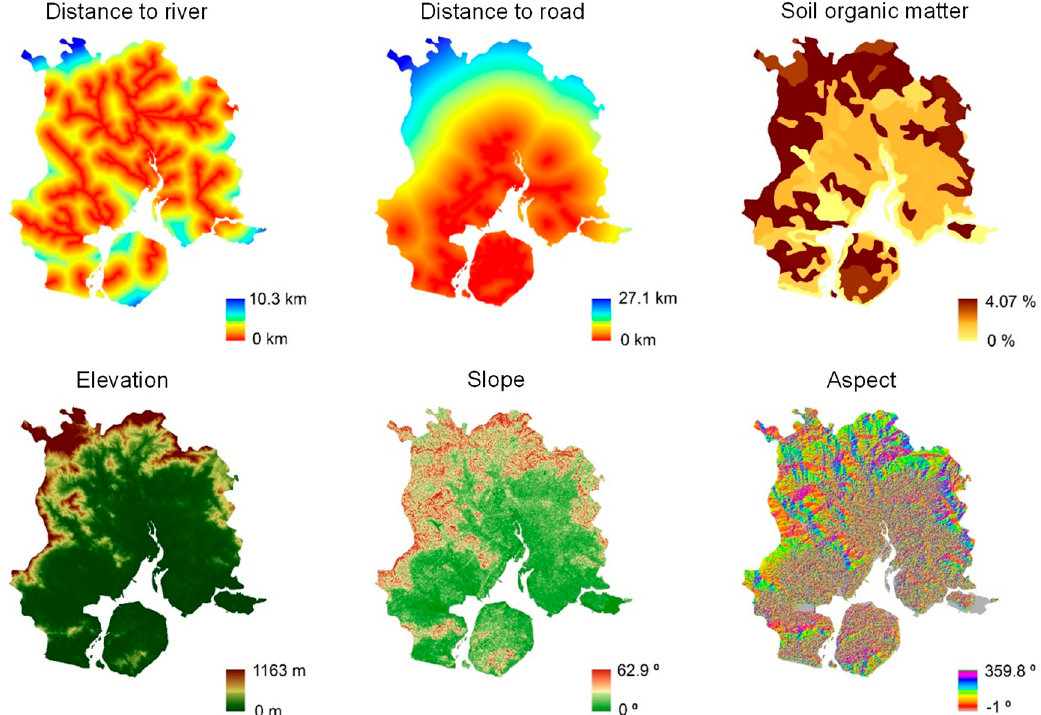
Figure 3. Spatial di ff erentiation of driving